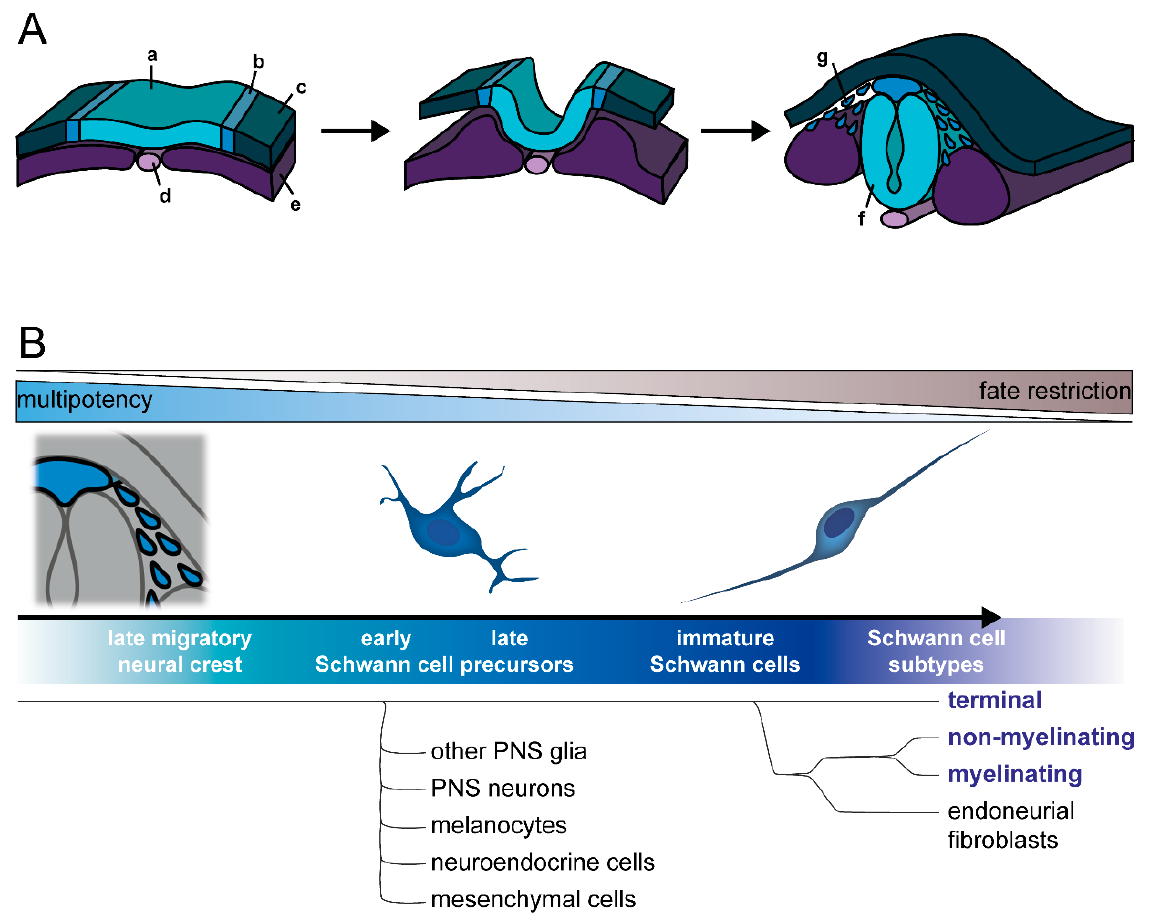
Figure 1. Development of the Schwann cell lineage . ( A ) During neurulation, the neural plate border (b) develops between the neural plate (a) and the non-neural ectoderm (c), along neighboring structures, including the notochord (d) and paraxial mesoderm (e). After the neural plate folds to build the neural tube (f), the neural plate borders merge and form the neural crest. Late neural crest cells (g) detach and migrate. ( B ) Differentiation along the Schwann cell lineage progresses through several intermediate stages, namely Schwann cell precursors and immature Schwann cells. While Schwann cell precursors are multipotent and can still differentiate into other cell types, such as melanocytes or neurons, immature Schwann cells are more fate restricted and differentiate into mature myelinating and non-myelinating Schwann cells, terminal Schwann cells of the neuromuscular junctions, as well as endoneurial fibroblasts. According to current knowledge, terminal Schwann cells segregate during differentiation prior to endoneurial fibroblasts and other Schwann cell subtypes.